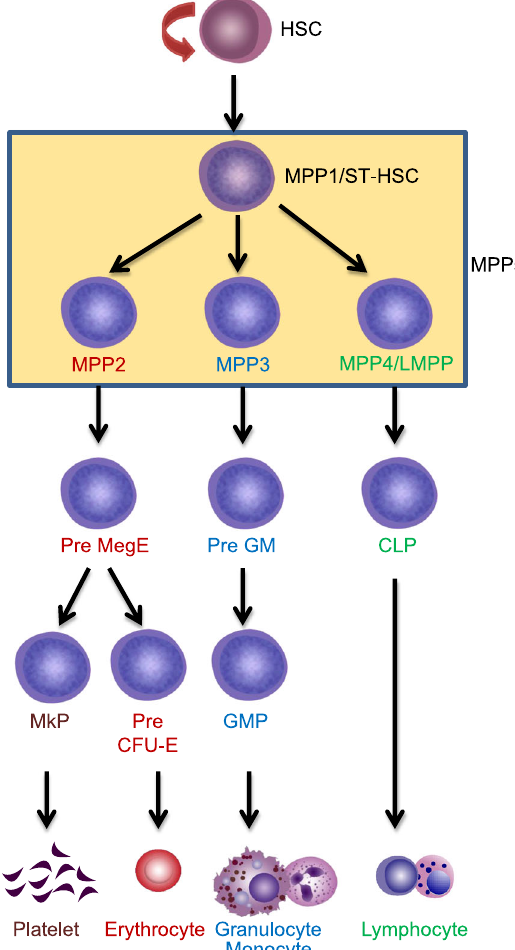
Figure 4. A reconciled model for hematopoietic stem cell differentiation. In this model, HSCs fi rst differentiate into MPP1/ST-HSC, then give rise to MPP2, MPP3 and MPP4 (LMPP). MPP2 can generate pre MegE, and subsequently, pre MegE gives rise to platelets through MkP or produce erythrocytes through Pre CFU-E. MPP3 mostly give rise to granulocyte and monocyte lineages, and MPP4 (LMPP) mainly contribute to